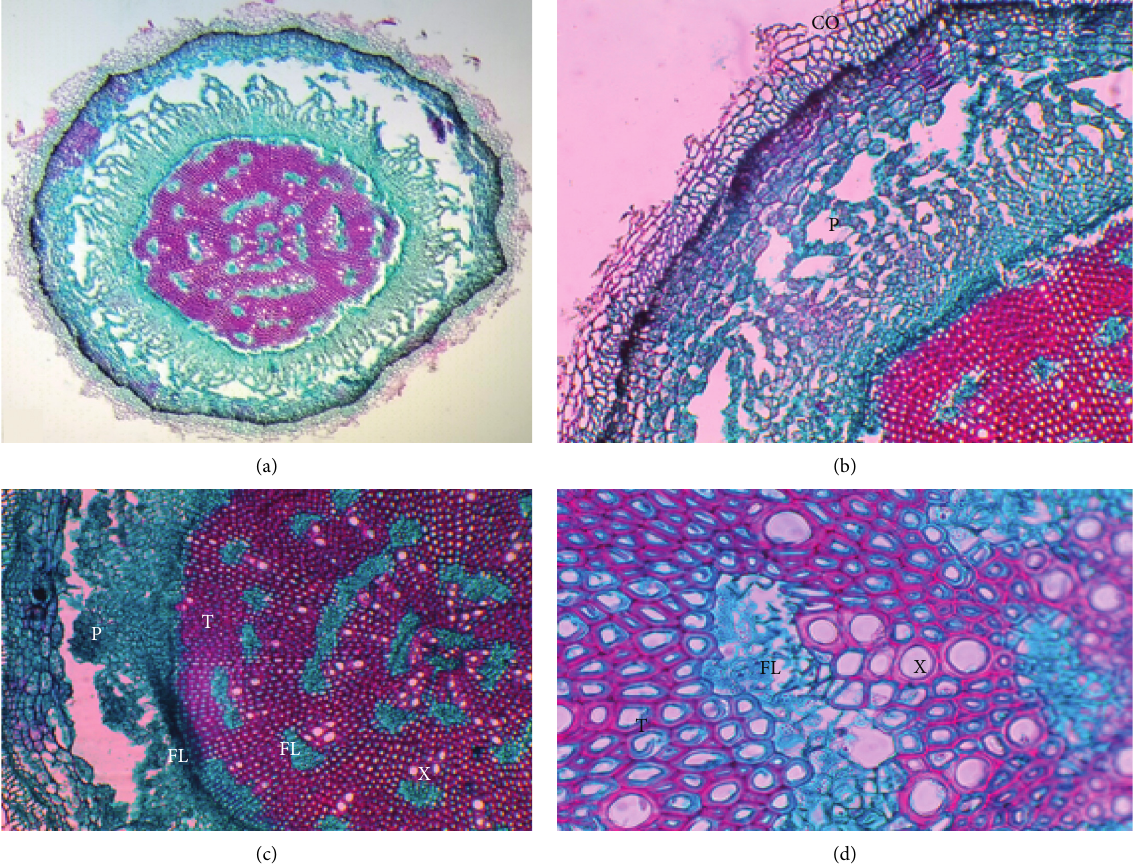
Figure 5: Image of apex cross section, El Yali National Reservation. Complete view of the stem, magnification 4X (a); collenchyma (CO), aerifer parenchyma (P), phloem (FL), and tracheids (T), 10X magnification (b); aerifer parenchyma (P), phloem (FL), tracheids (T), phloem (FL), and xylem (X), 10X magnification (c); tracheids (T), phloem (FL), and xylem (X), 40X magnification